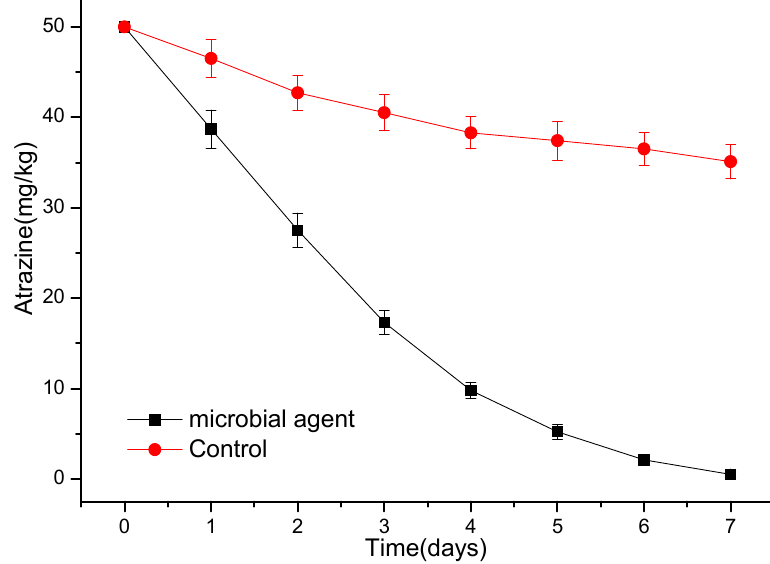
Figure 9. The curve of the degradation of atrazine in soil by a microbial agent.